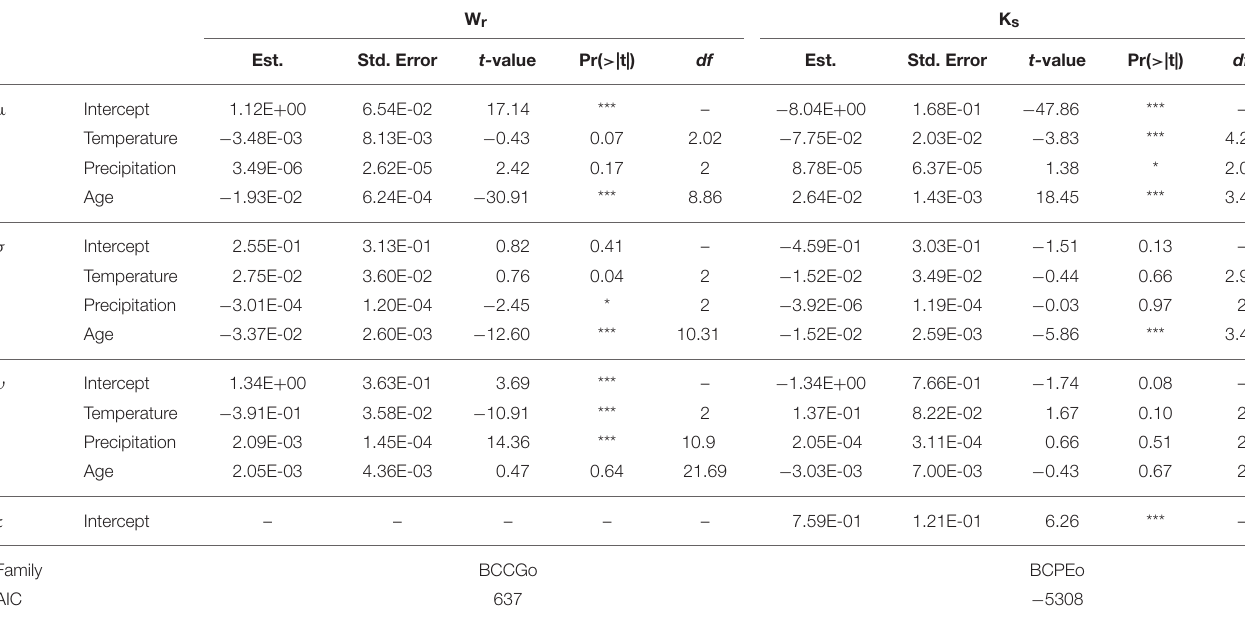
TABLE 1 | Summary statistics for the best fitted GAMLSS for tree-ring width (W r ) and specific hydraulic conductivity (K s )